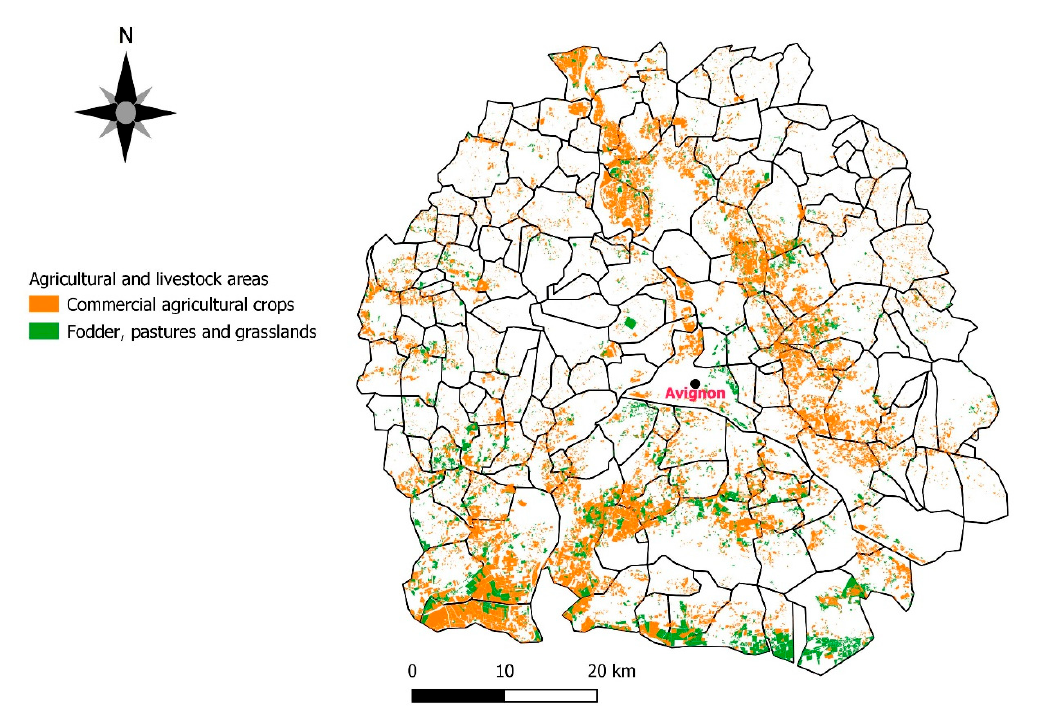
Figure 5. Distribution of commercial agricultural crops, excluding vineyards, and areas dedicated to feeding livestock (fodder, pastures and grasslands) in the foodshed. Our own elaboration based on the RPG map [47].